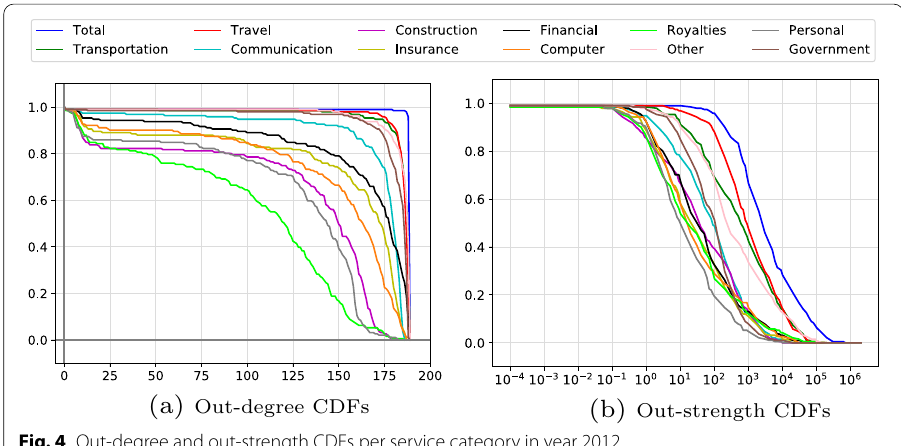
Fig. 4 Out-degree and out-strength CDFs per service category in year